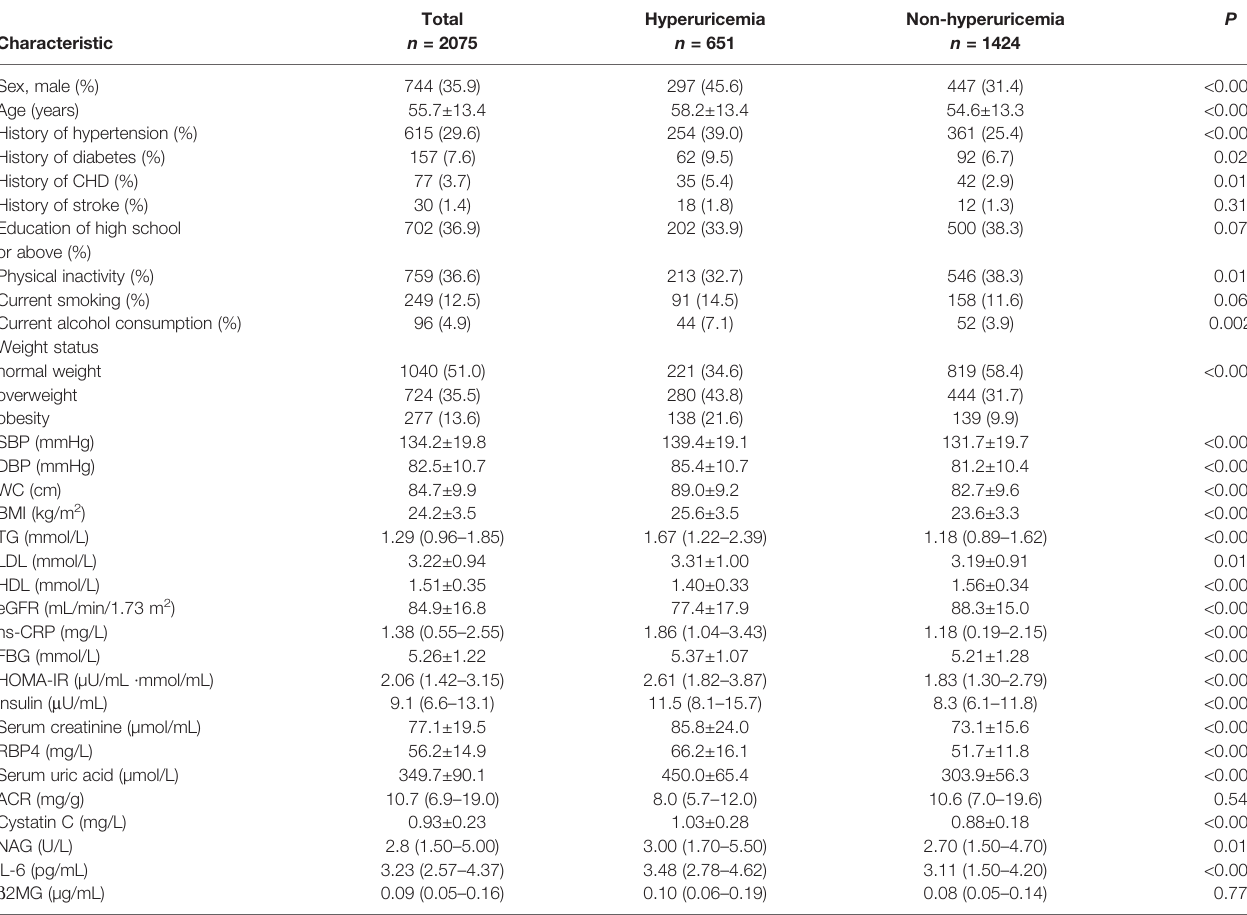
TABLE 1 | Participant baseline